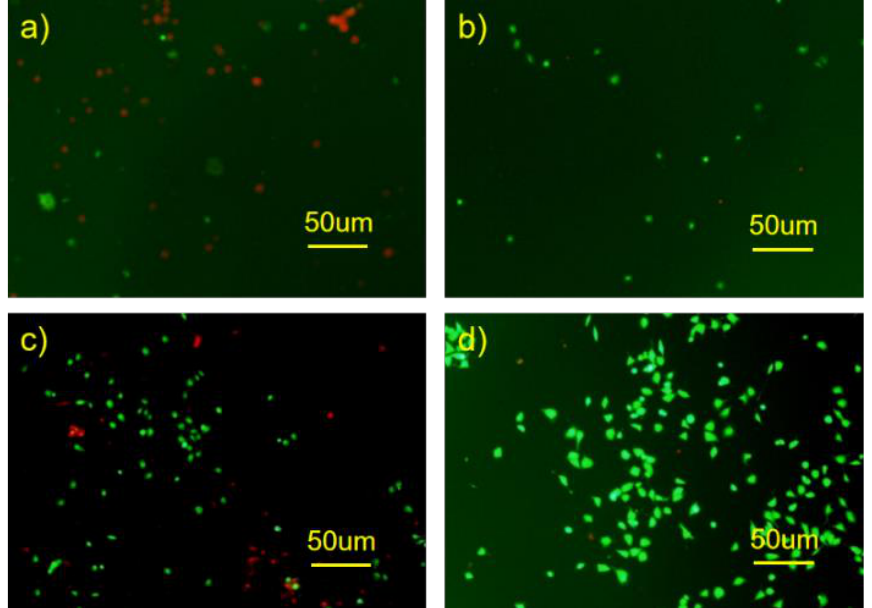
Figure 11. Fluorescence images of HUVECs attached directly on bare Mg and coated Mg alloy after in vitro culture for 24 h, where live cells fluoresce green and dead cells fluoresce red (( a ) bare Mg ( b ) HF-Mg ( c ) PLLA (5)-HF-Mg ( d ) PLLA